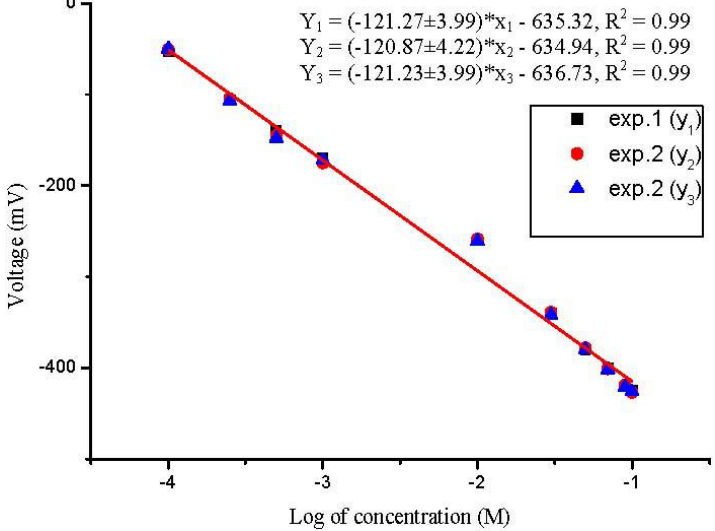
Figure 4. Calibration curves showing the biosensor repeatability at room temperature